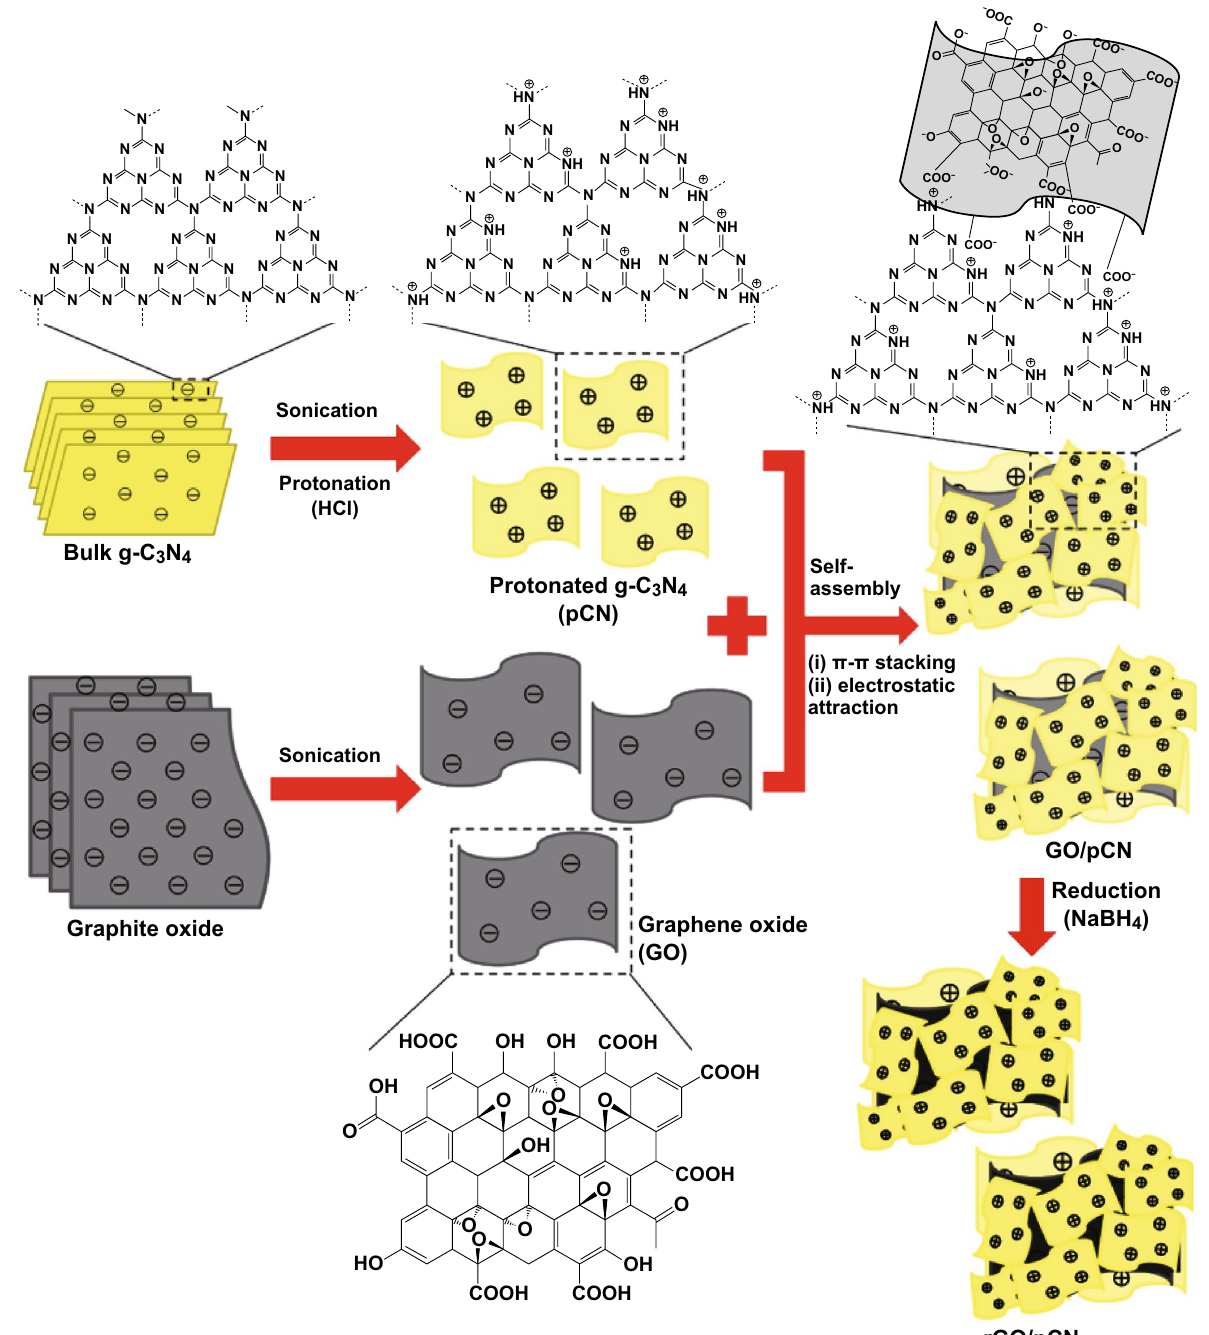
Fig. 15 Schematic diagram for the synthesis process of rGO/pCN samples via a combined ultrasonic dispersion and electrostatic self-assembly strategy followed by a NaBH 4 -reduction process. Reproduced with permission from Ref. [109]. Copyright permission from Elsevier. (Color fig- ure